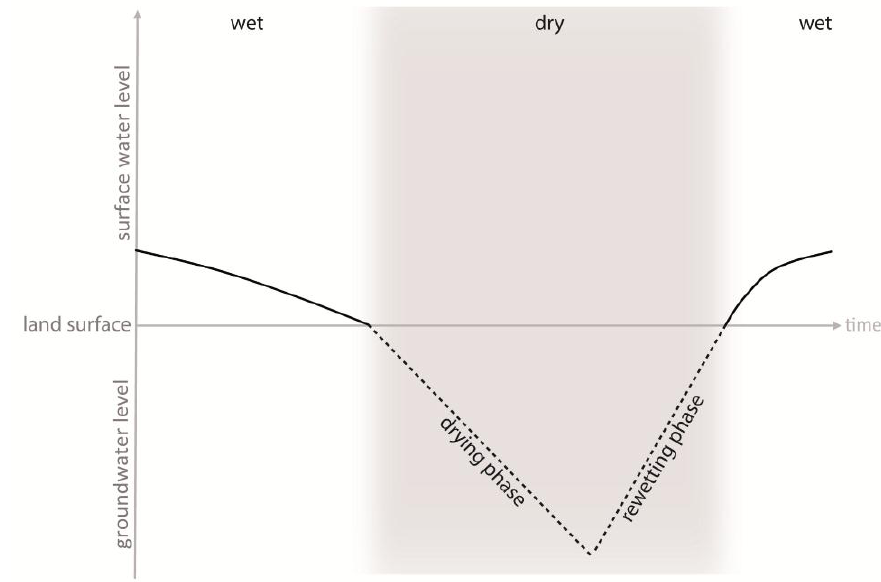
Figure A1. Conceptual model of the drying and rewetting approach modified from